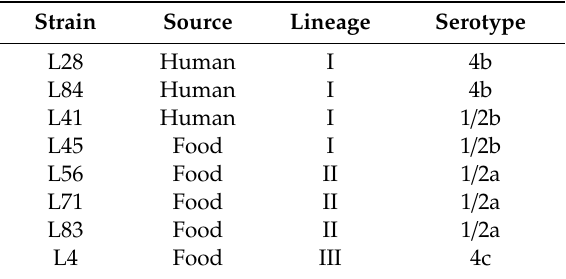
Table 1. L. monocytogenes strains used in the